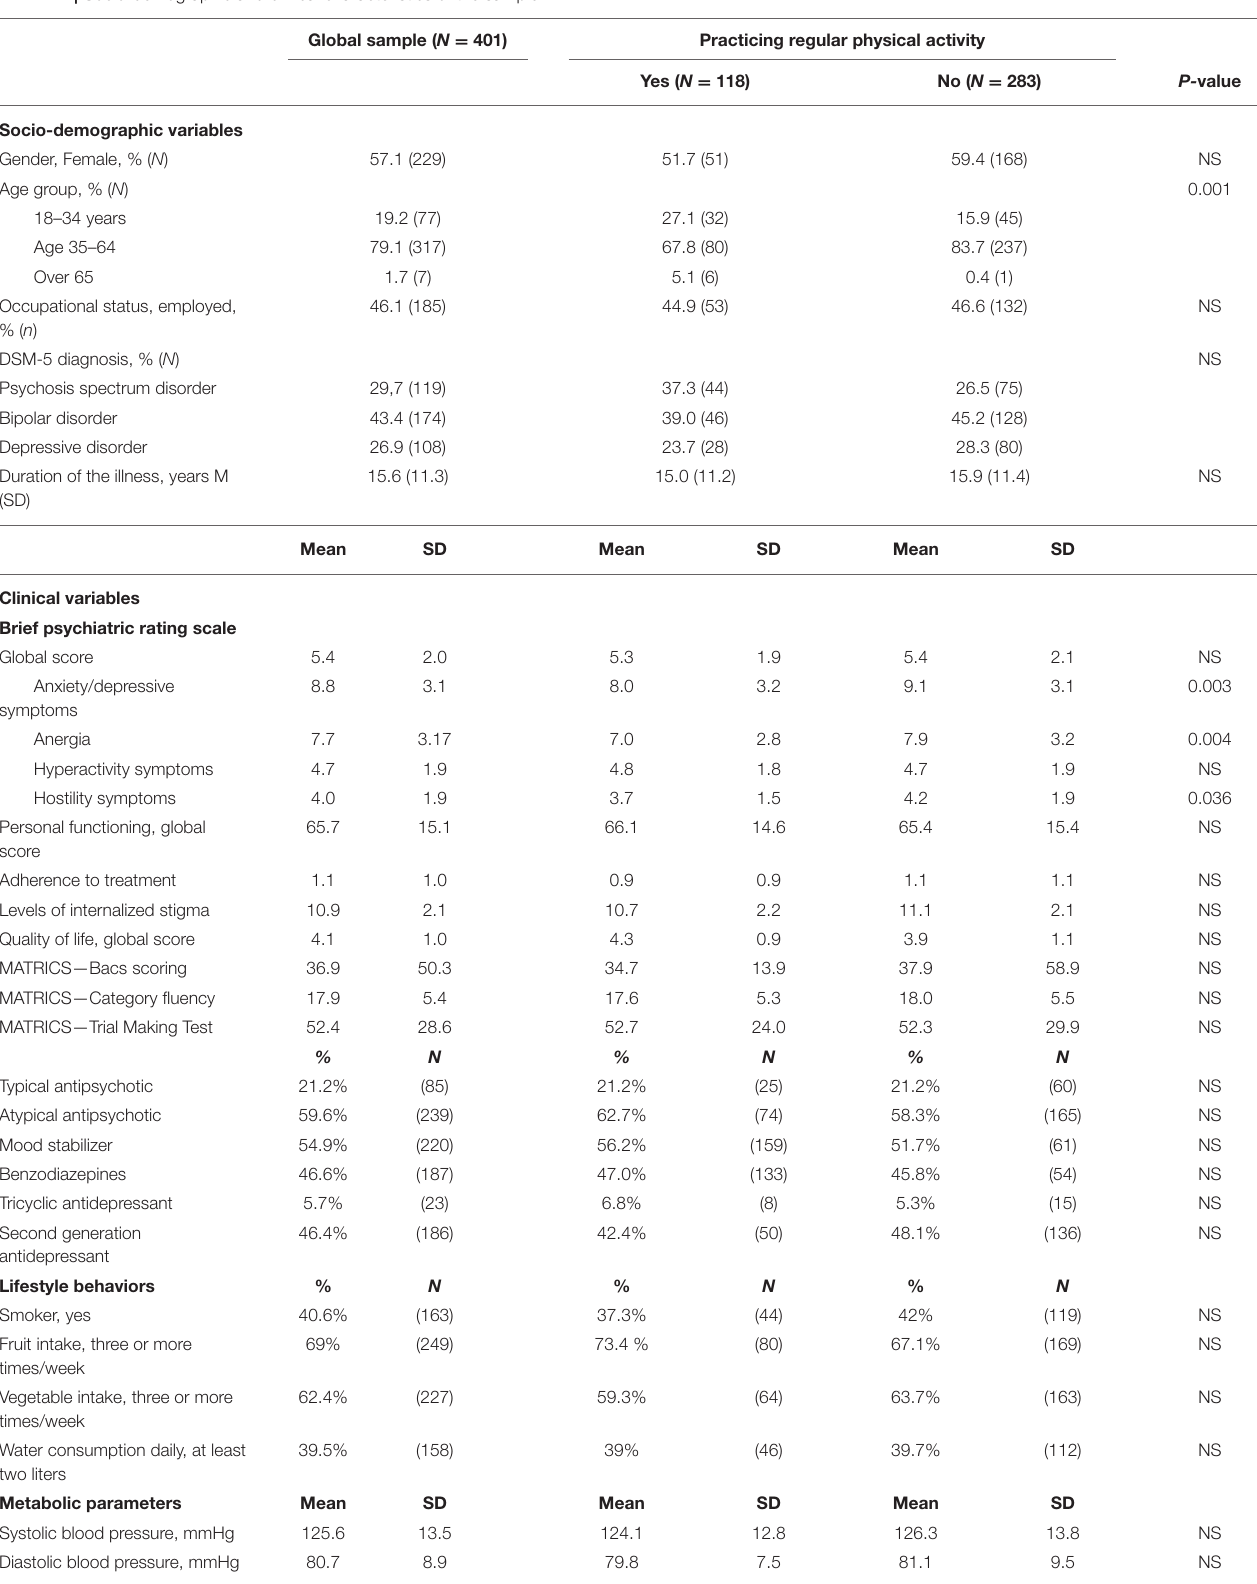
TABLE 1 | Socio-demographic and clinical characteristics of the sample. Global sample ( N = 401) Practicing regular physical